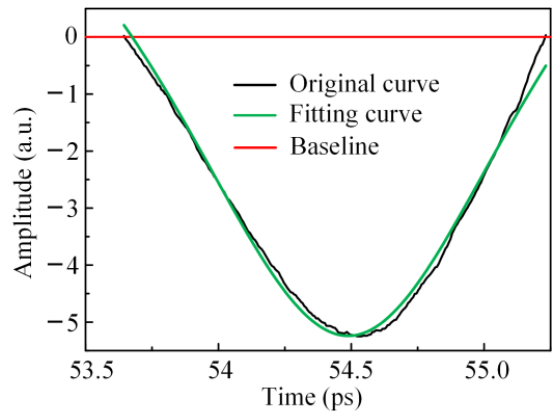
Figure 6. Result of unimodal fitting for terahertz time-domain spectroscopy.